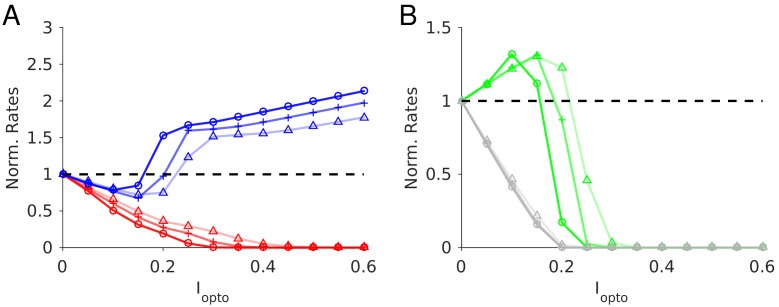
Model 1 with JEE<JEE*.Robustness with respect to change in the average connectivity, K. Triangles: K = 500; cross: K = 1000; circles: K = 2000. Nα = 10000 neurons per population. Baseline firing rates: K = 500: rE = 4.7 Hz, rI = 11.2 Hz, rS = 7.1 Hz, rV - 5.2 Hz; K = 1000: rE = 4.1 Hz, rI = 10.3 Hz, rS = 7.6 Hz, rV = 4.7 Hz; K = 2000: rE = 3.7 Hz, rI = 9.7 Hz, rS = 7.8 Hz, rV = 4.4 Hz. Rates are averaged over 10s. Color code and parameters as in Figure 7.